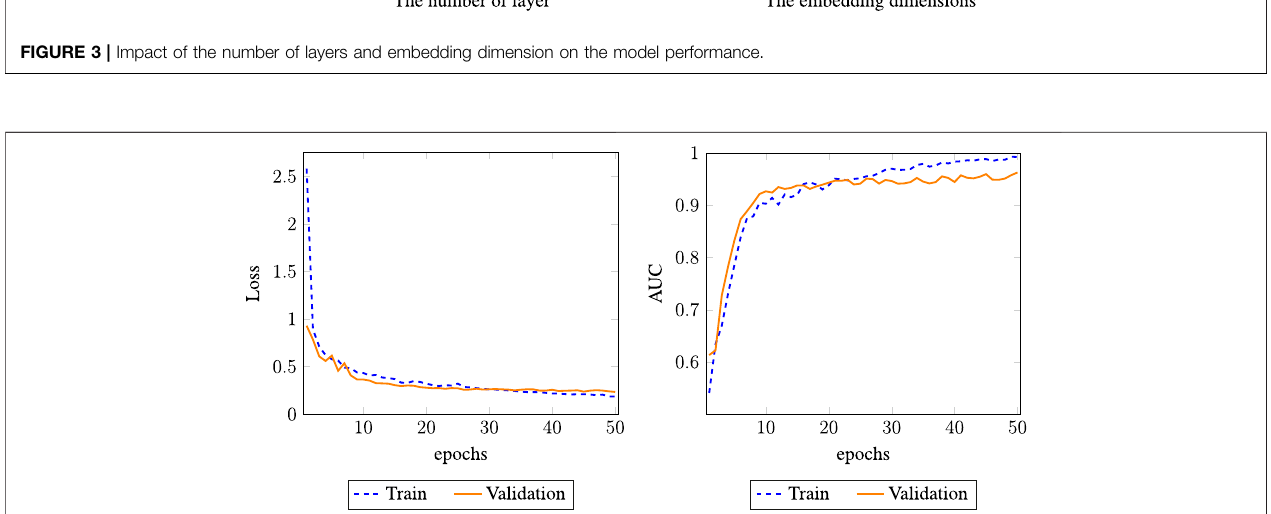
FIGURE 4 | AUC and loss history plot for DR-HGNN on each epoch for the training and validation datasets.